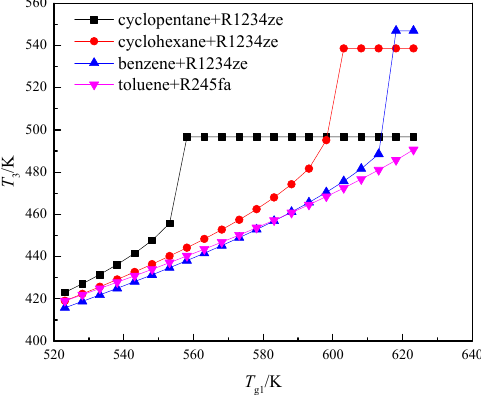
Figure 8. Effects of T g1 on the optimal HTL evaporation temperature.